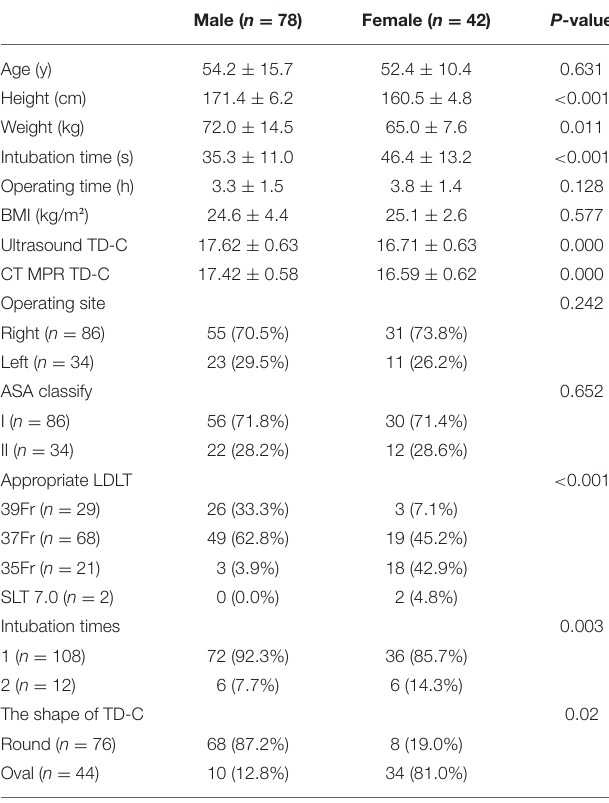
TABLE 1 | Comparison of general conditions of male and female patients.